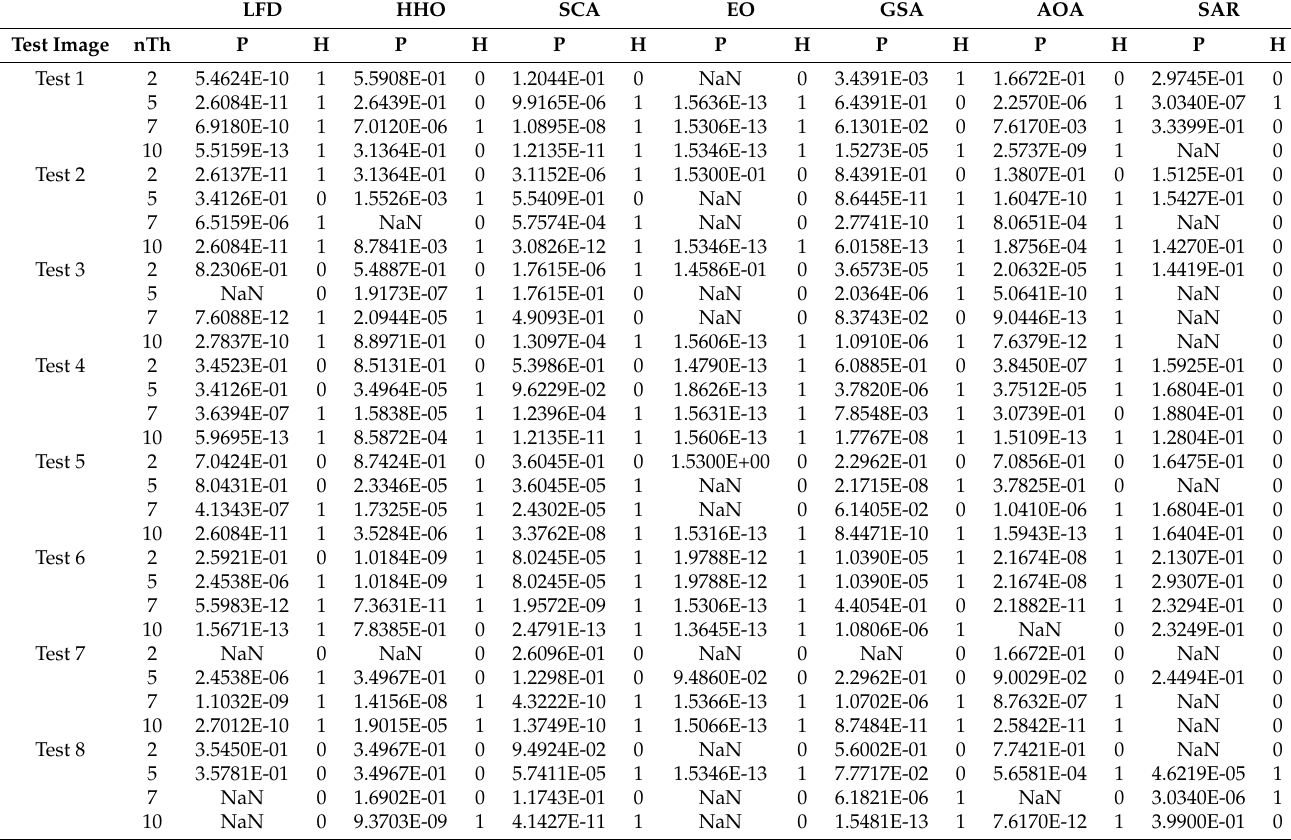
Table A4. Comparison of the p -value and H-value obtained by the Wilcoxon signed-rank test between the pairs of mSAR vs LFD, mSAR vs HHO, mSAR vs SCA, mSAR vs EO, mSAR vs GSA, and mSAR vs AOA for fitness outcomes using the Otsu